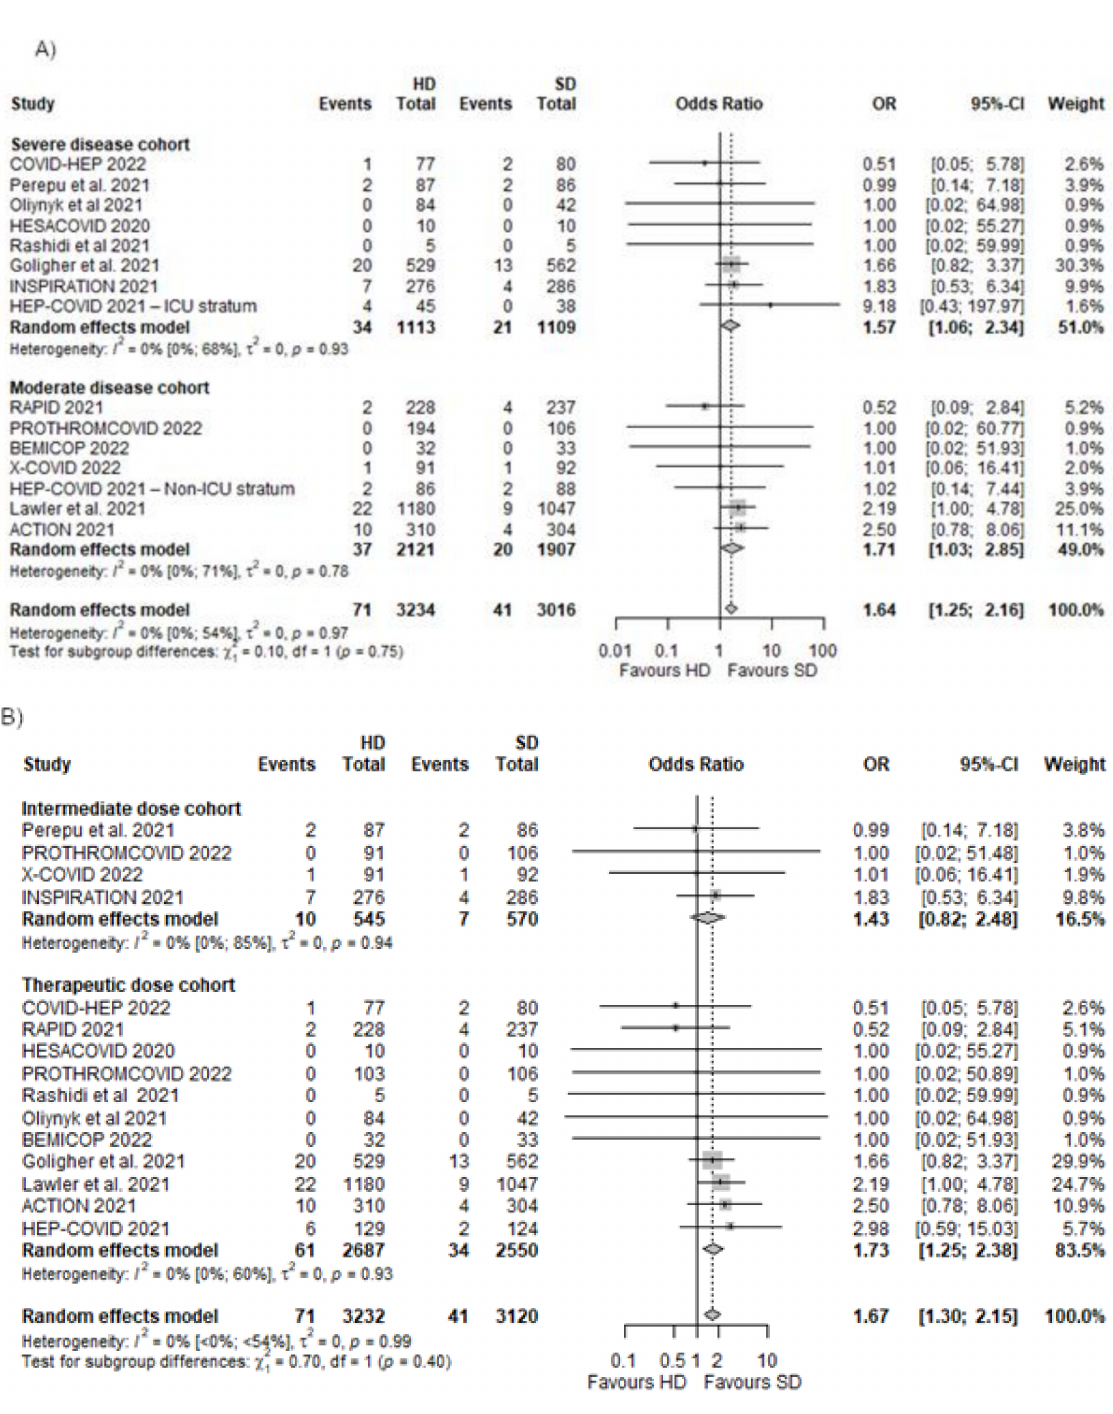
Figure 5. Major bleedings in different dosing regimens in moderate and severe disease cohorts [20–25,50–56]. ( A ) Major bleeding events in severe and moderate disease cohorts; ( B ) major bleeding events in cohorts where intermediate or therapeutic dose was used in the HD